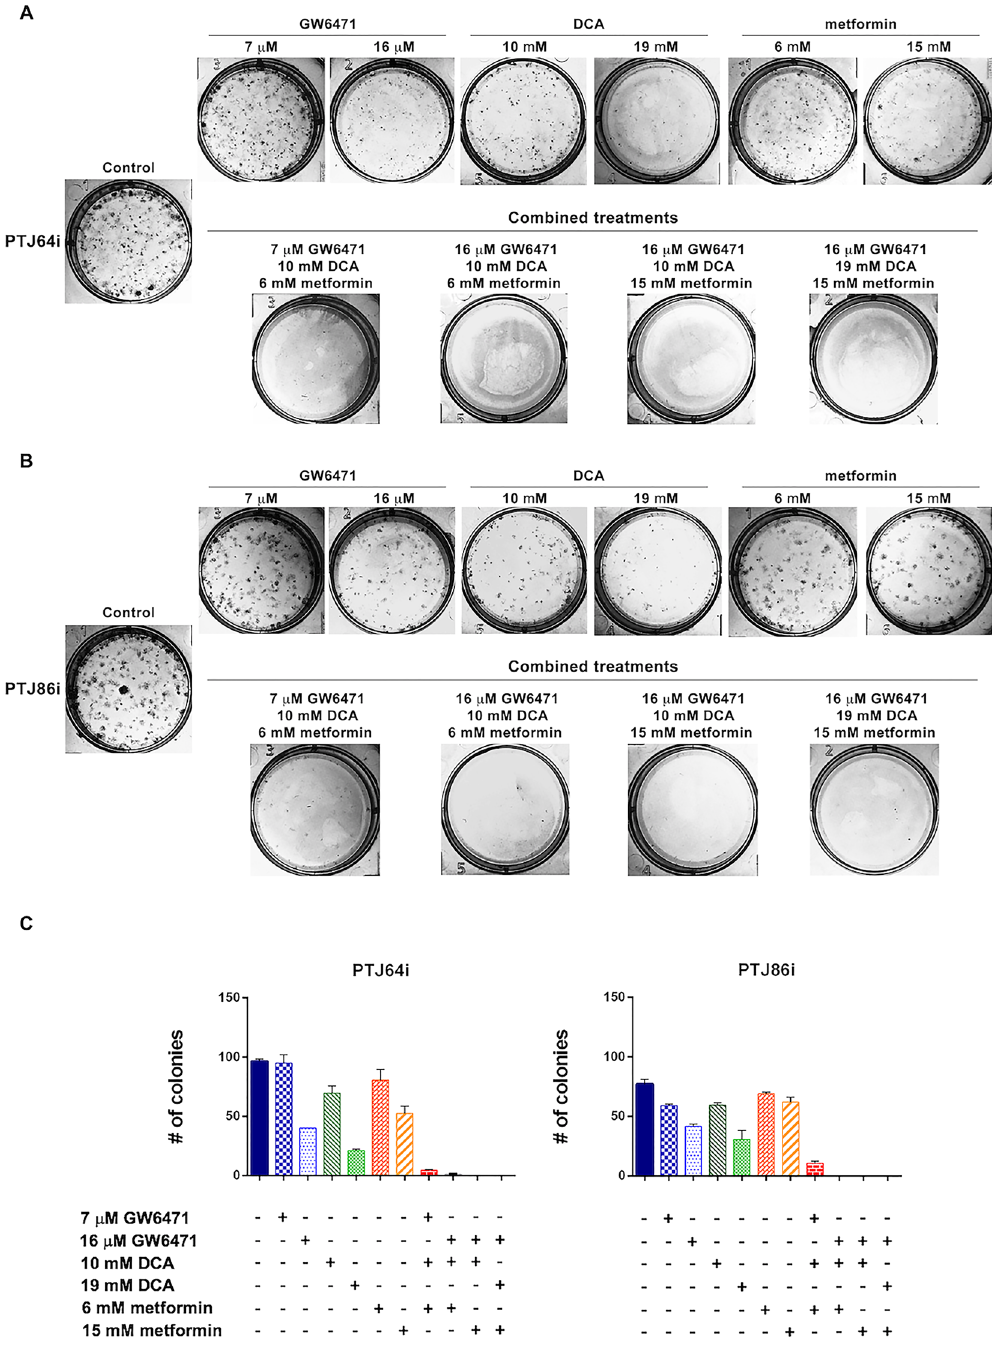
Figure 9. Effect of DCA, GW6471 and metformin as single agents or in combinations on PGL clonogenic capacity. (A,B) Representative plates of colony formation assays for PTJ64i (A) and PTJ86i (B) are shown; (C) Histograms represent quantitative analyses of colony formation assay in PGL cells. Data shown are the means ± SD of two independent